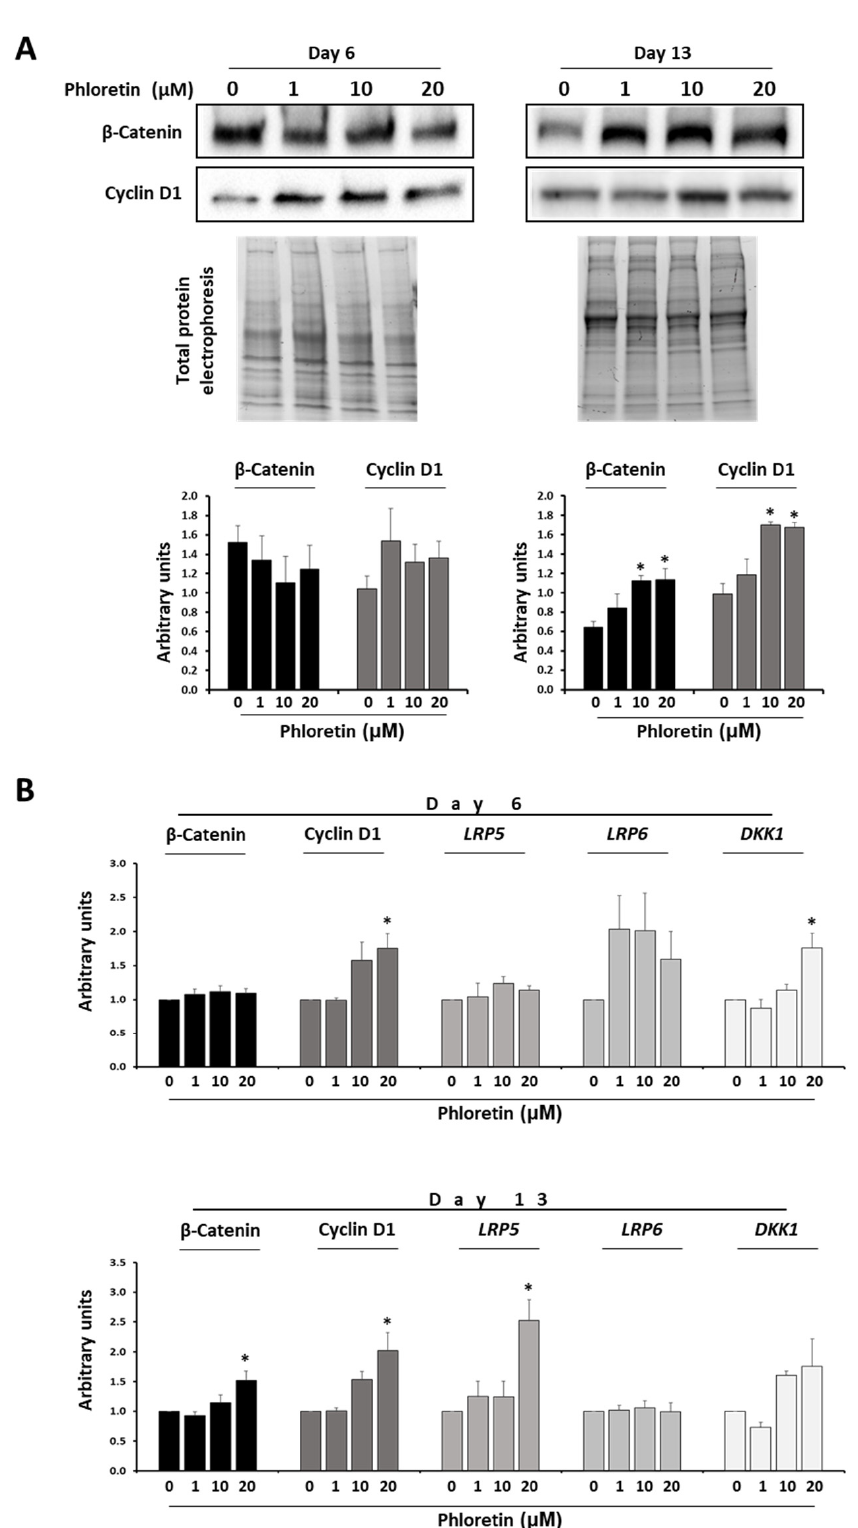
Figure 6. Phloretin affects the Wnt/ β -catenin pathway. ( A ) Protein levels of β -catenin and cyclin D1 by Western-blot, at days 6 and 13 of adipogenic differentiation, in presence of 0, 1, 10, and 20 µ M of phloretin. Results of the quantification of Western blot bands are shown in the graphs. ( B ) Gene expression of β -catenin, cyclin D1, LRP5, LRP6, and DKK1 (related to the Wnt/ β -catenin pathway), at days 6 and 13 of culture treatment. * p < 0.05 vs. cultures no treated (0 µ M of phloretin). Low-density lipoprotein receptor-related proteins 5 and 6 (LRP5 and LRP6) are key components of the LRP5/LRP6/Frizzled co-receptor group, being involved in the canoni- cal Wnt/ beta-catenin pathway [44]. On the other hand, Dickkopf-related protein 1 (DKK1) is an antagonist of the Wnt/ β -catenin pathway that acts by preventing LRP5/LRP6 co-